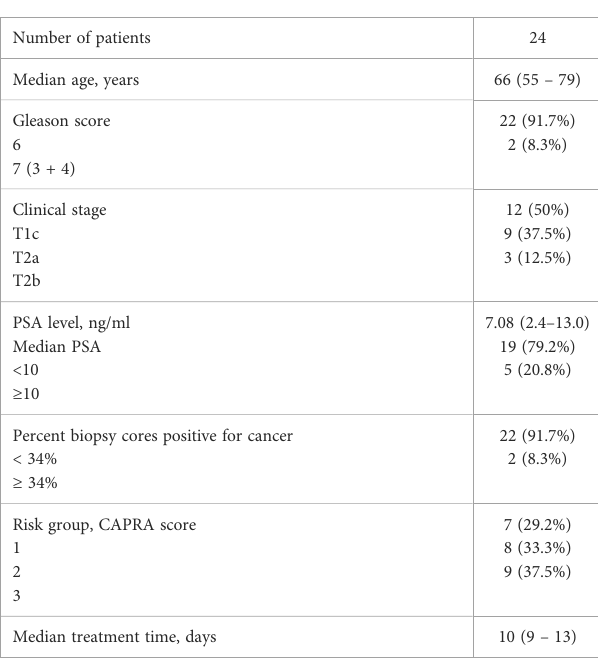
TABLE 1 Baseline characteristics of the